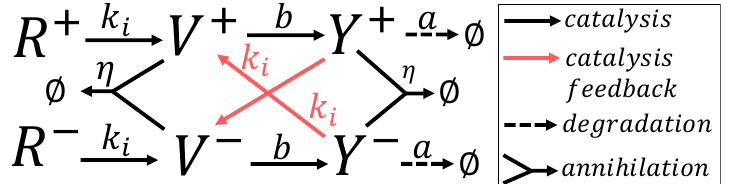
Figure 5. Dual-rail representation for the CRN of the catalysis, degradation, and annihilation reactions for realising integral control employing the